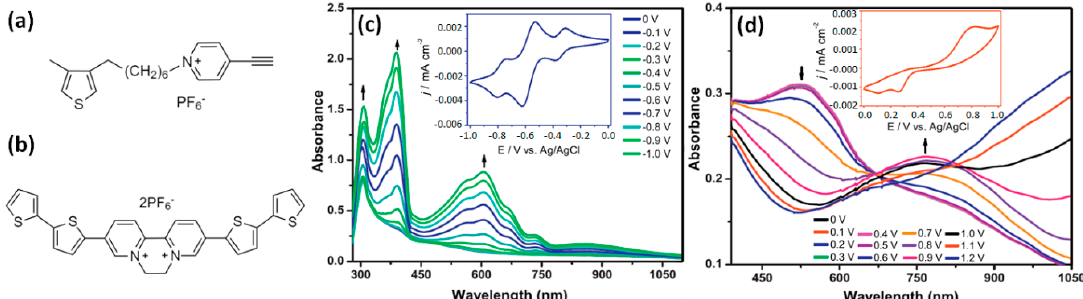
Figure 9. ( a ) The chemical structure of Th-CN monomer. ( b ) The chemical structure of the bt2dq 2+ monomer. In situ UV–Vis specta for the PTh-V film deposited on ITO electrode inBmimPF6 recorded under different applied potentials from ( c ) 0 V to − 1.0 V and ( d ) 0 V to 1.2 V in steps of 0.1 V. Readapted with permission from Elsevier Ltd. [69,79].